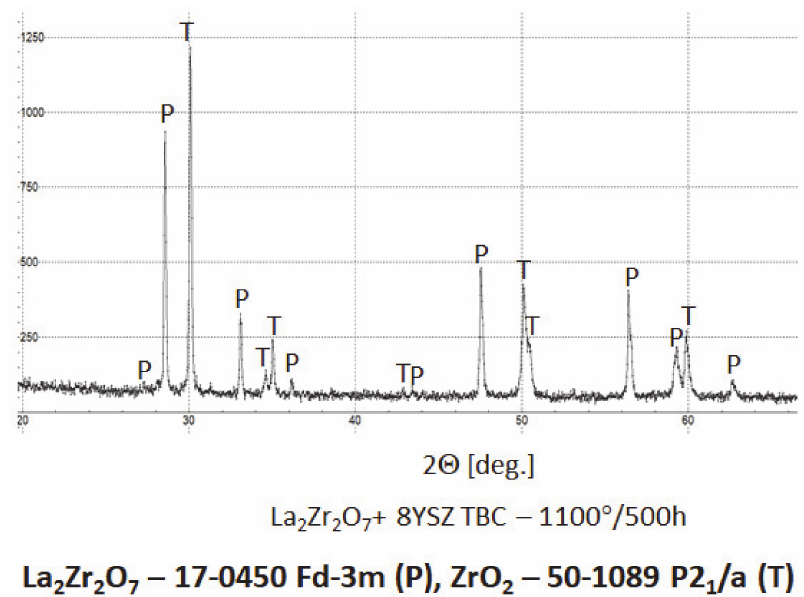
Figure 28. Phase composition of the ceramic top-coat of 0% La 2 Zr 2 O 7 + 50% 8YSZ TBC composite after oxidation test at 1100 ◦ C with 500 h of